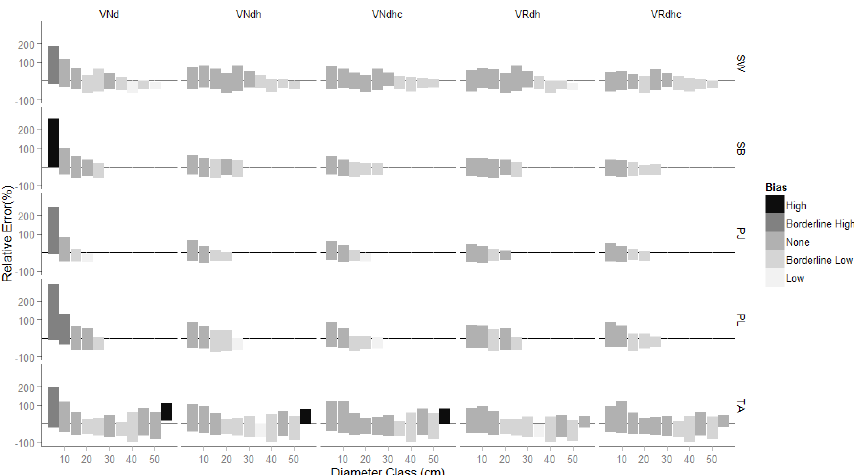
Figure 1. Relative error in estimation of volume increment from DBH reconstructed from tree-ring data, in comparison to volume increment derived from whole stem analysis for the same trees. Errors are plotted by species (rows) and 5 cm DBH class. The bars represent the range of the 2.5th and 97.5th percentiles of the relative errors in each class. Bars are plotted in different shades as a function of the percentile location of zero with the distribution of errors in a diameter class, and interpreted as described in the text. The columns represent different potential methods for estimating volume increment, national equations using DBH only (VNd), national equations using DBH and raw HT (VNdh), national equations using DBH and corrected height (VNdhc), regional equations using DBH and raw HT (VRdh), and regional equations using DBH and corrected height (VRdhc).